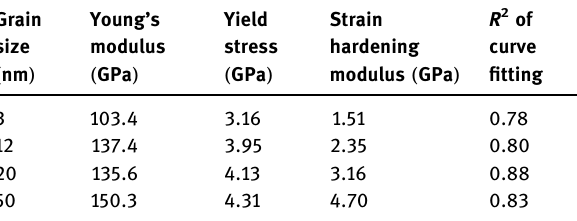
Table 1: Material parameters from the stress – strain curves for di ff erent grain sizes